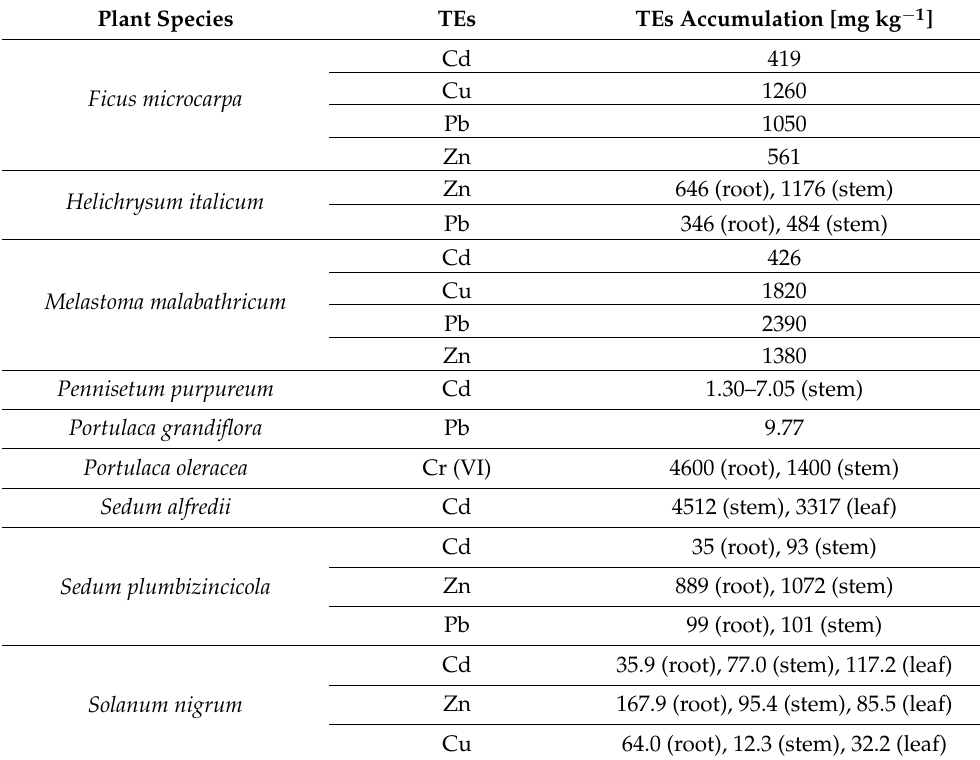
Table 3. Selected phytoremediation plant species of green roofs